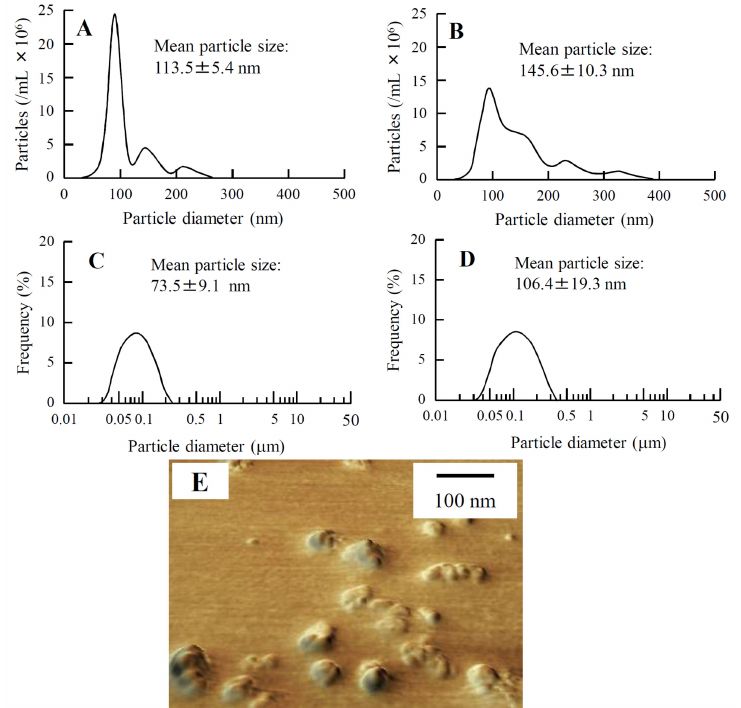
Figure 1. Size frequency distribution of the MH particles in nCMFC just after the bead mill treatment ( A , C ) or 8 days after bead mill treatment ( B , D ). The size frequency distributions were measured by using the NANOSIGHT LM10 (QuantumDesign Japan, Tokyo, Japan) ( A , B ) and SALD-7100 ( C , D ); ( E ) shows the scanning probe microscopy (SPM) image of nCMFC just after bead mill treatment. The MH particles in nCMFC remained in the nano size range for 8 days after bead mill treatment.